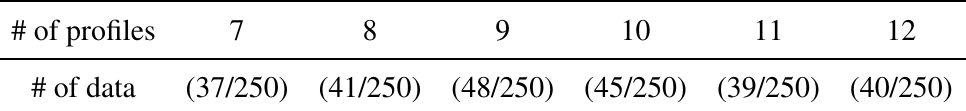
Table 4. The number of profiles according to the number of data.